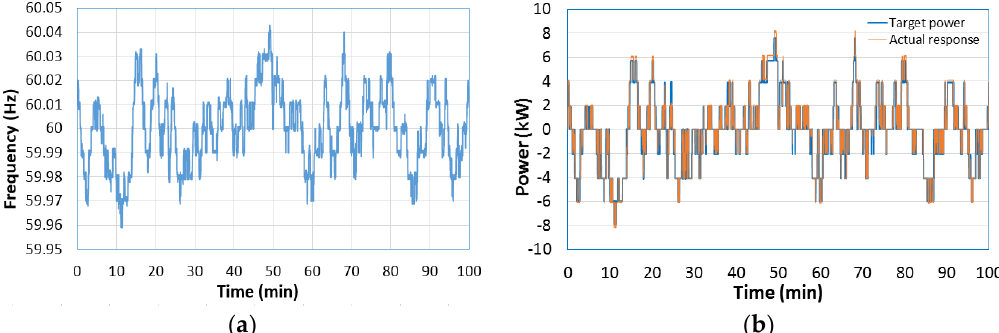
Figure 12. ( a ) Frequencies produced by grid simulator in AC mains and monitored by power analyzer and ( b ) droop control-based AC target power for DCFC/EV and AC output actual power responding from DCFC/EV (positive: charging, negative: discharging) for PFC at the CCHT-V2G facility.